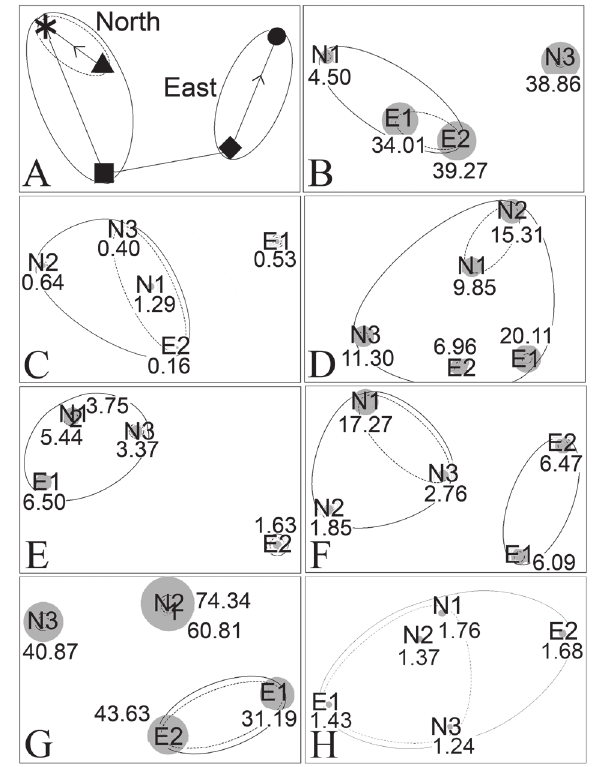
Fig . 6. – mdS plots built up using measures of taxonomic dissimi- larity index ( Γ + ) between pairwise “Site” comparisons (presence/ab- sence data); 2d-stress is equal to zero in all pictures. clusters at 20% (dashed contour) and at 30% dissimilarity (continuous contour) are overlaid. Standardised taxon abundances and scaled bubbles are also superimposed. none-detectable sclerobiontic sponges were found at n2. A, total epifauna on Pinna nobilis ; trajectory line joins sites according to n-ne-e geographic gradient. B, Porifera. c, cni- daria. d, mollusca. e, Annelida. f, Arthropoda. G, Lophophorata. h, tunicata. the species-poor phylum echinodermata is not shown. legend : triangle, echaâra (n1); asterisk, njila (n2); square, Sidi Rais (n3); rhomb, Stah Jaber (e1); circle, téboulba